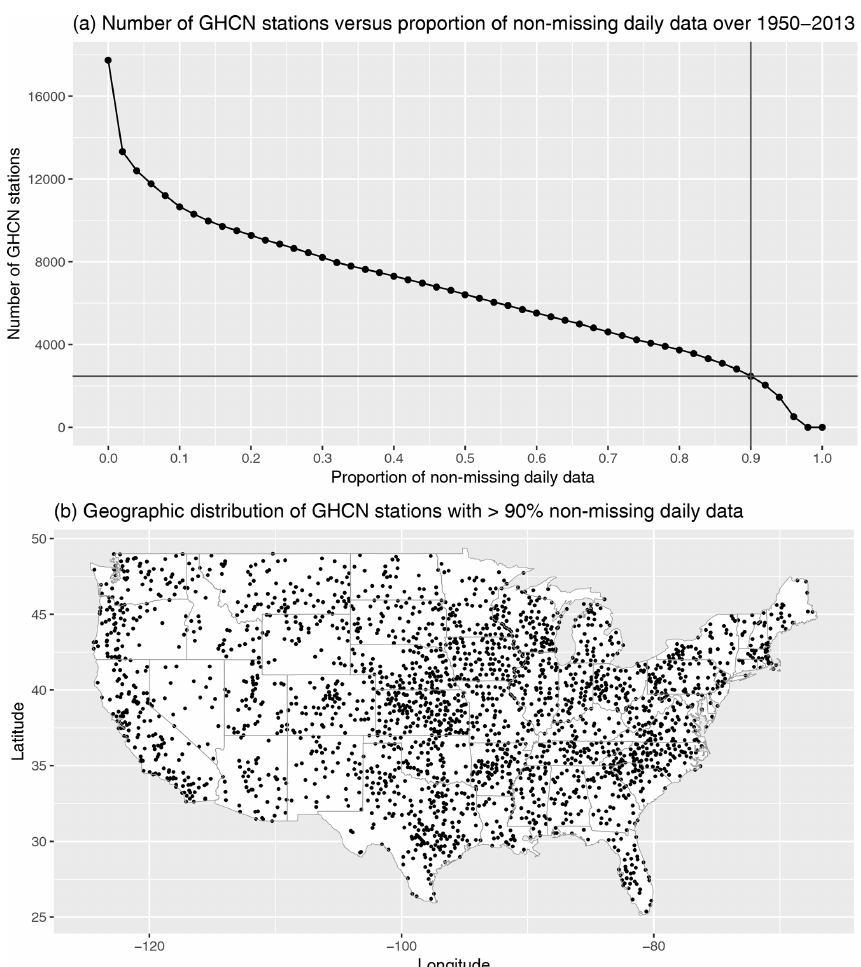
Figure A1. The number of GHCN stations versus the proportion of non-missing daily data over 1950–2013 threshold, with the 90% threshold used in this paper to define the n = 2474 “high-quality” stations (a) . The geographic distribution of the high-quality GHCN stations with at least 90% of non-missing daily measurements over 1950–2013 (b)